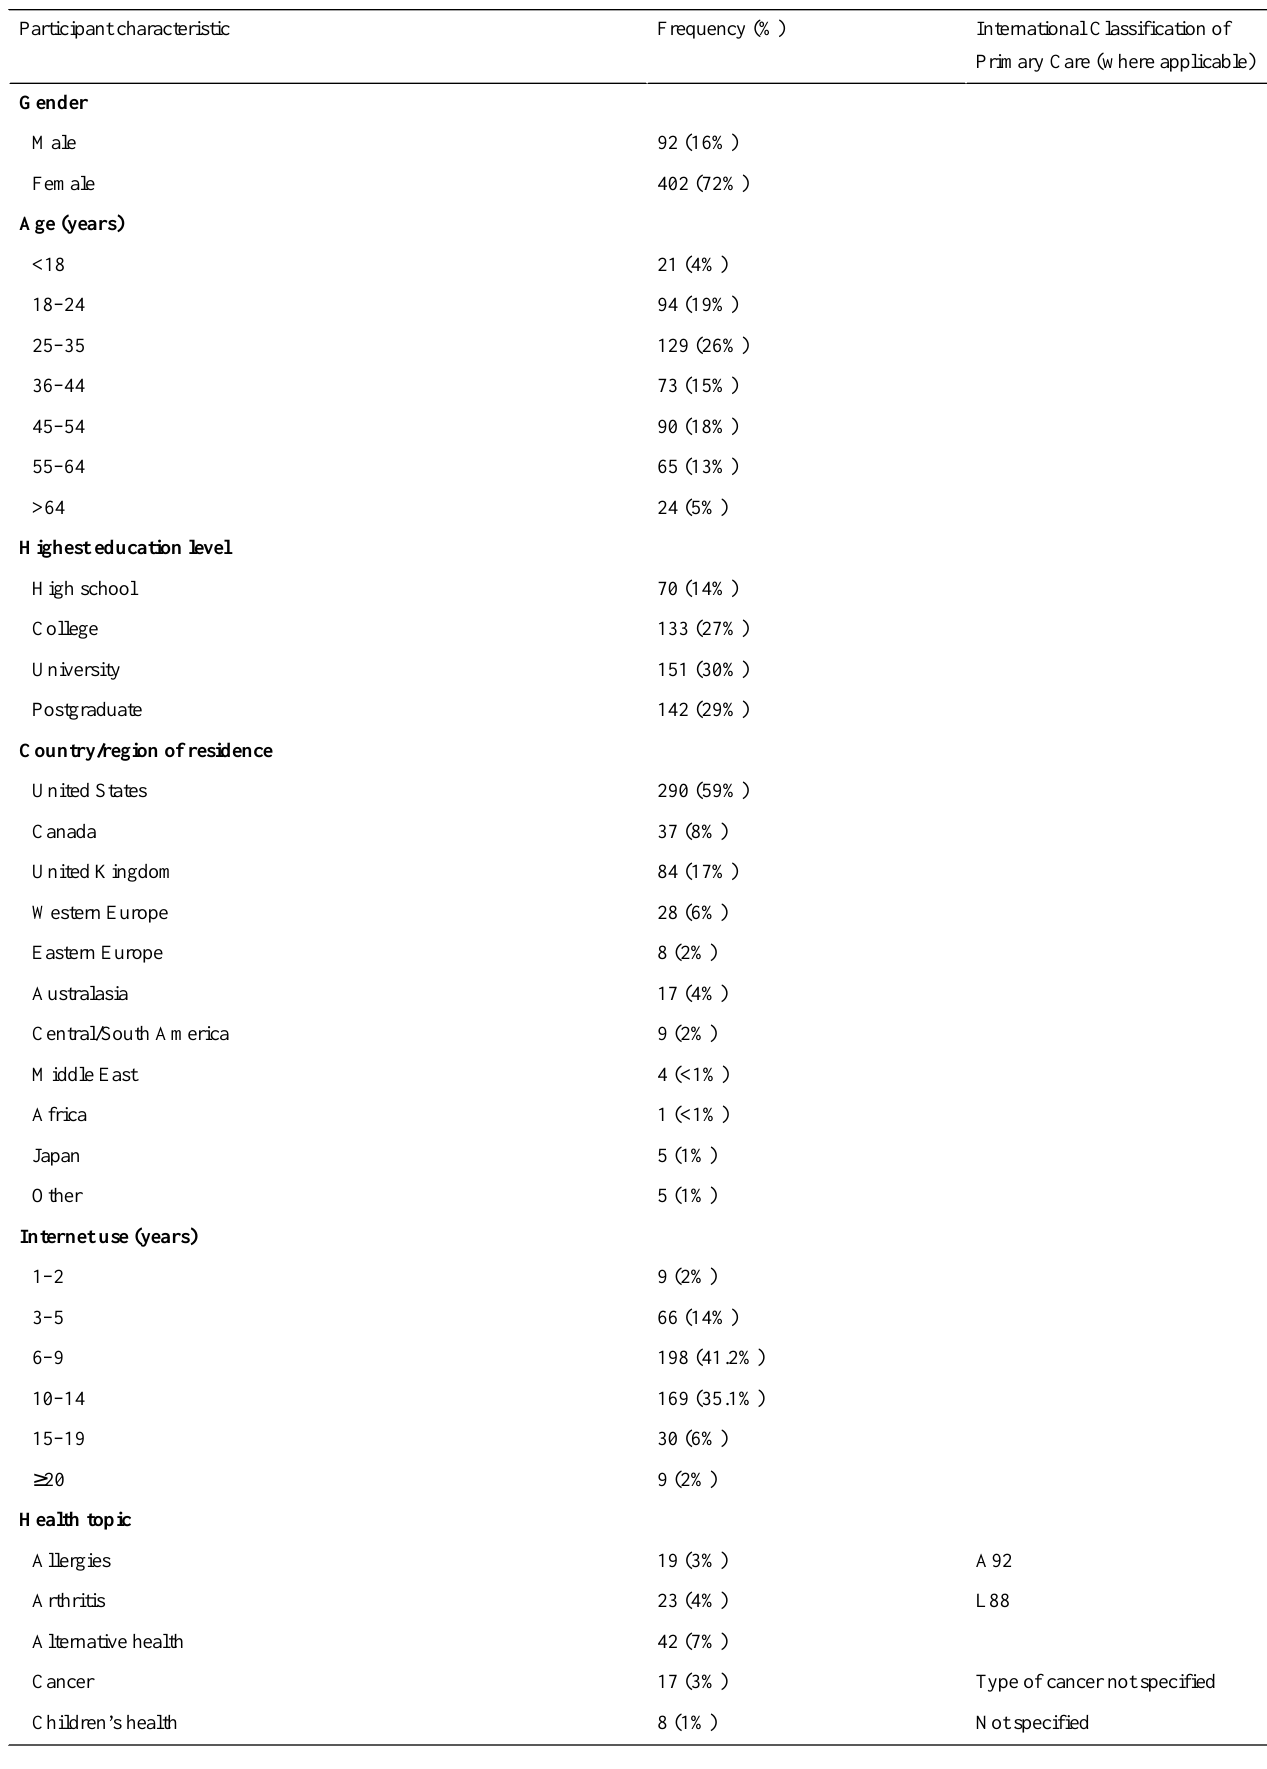
Table 1. Background characteristics of participants and the health topics searched